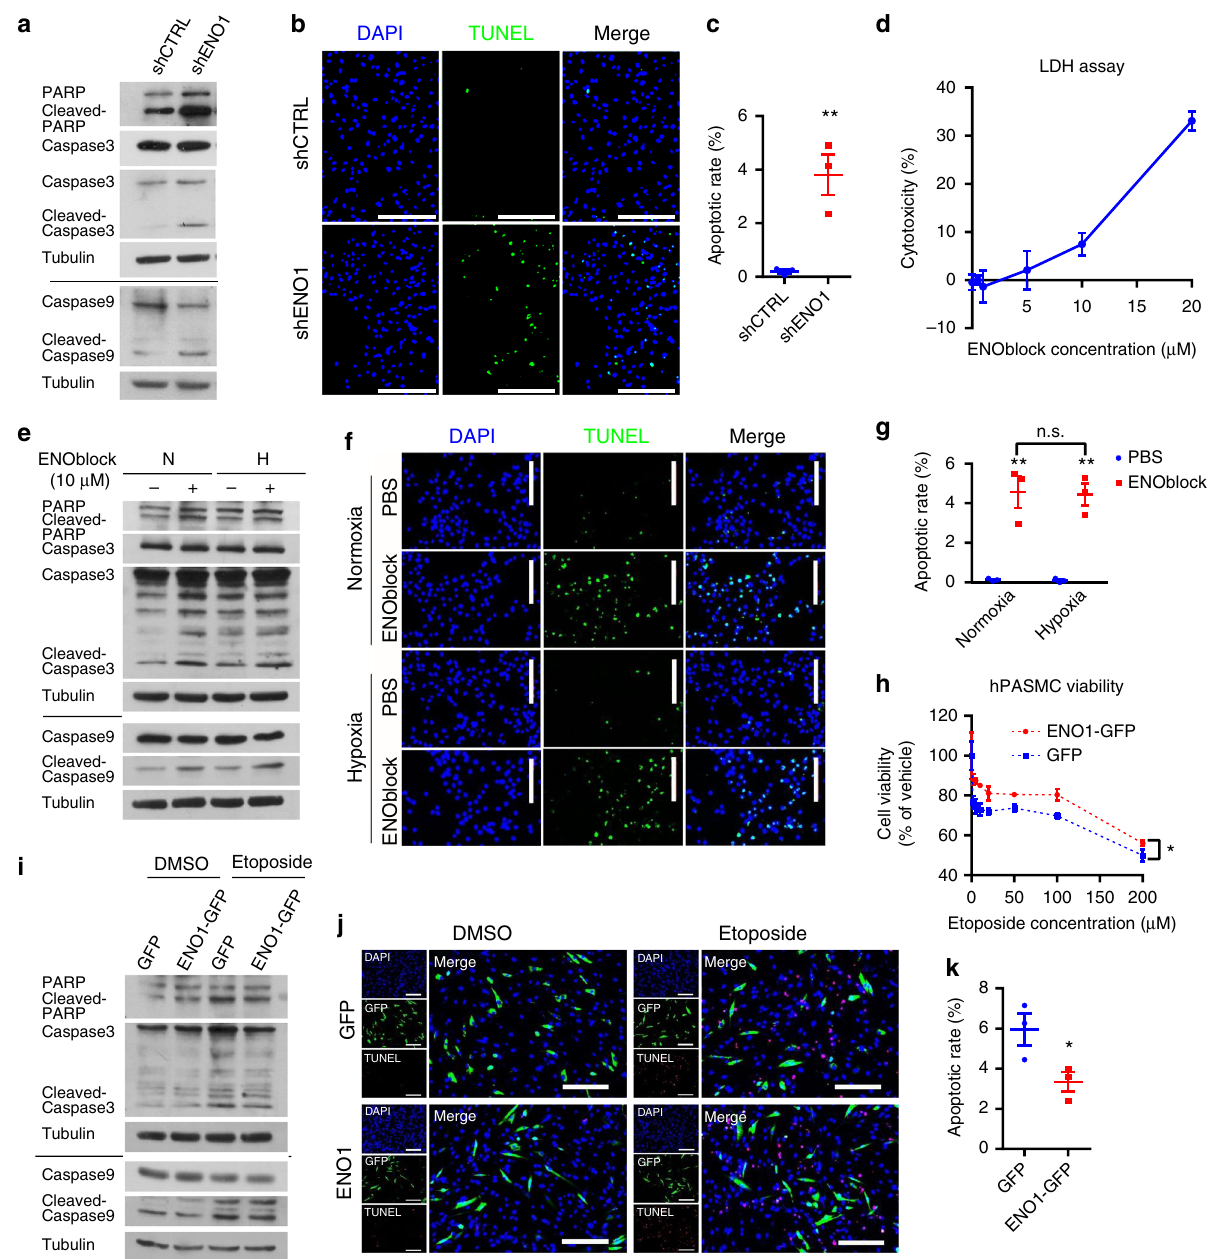
Fig. 3 ENO1 induces PASMC resistance to apoptosis. a The amount of apoptotic markers: PARP (full length and cleaved), caspase 3 (full length and cleaved), caspase 9 (full length and cleaved) were detected by western blotting in shENO1 – PASMC. b shENO1 and shCTRL PASMC were subjected to the TUNEL assay (Scale bars, 100 μ m) and c the apoptotic rates were calculated ( n = 3, ** P < 0.0001) with the TUNEL assay in shENO1 – PASMC. d PASMC were treated with ENOblock in different concentrations for 24 h, and the LDH assay was performed to detect cell death. e PASMCs were treated with 10 μ M ENOblock and hypoxia (1% O 2 ) for 24 h, and western blotting was used to detect apoptotic markers in cell lysate. f Images of the TUNEL assay (Scale bars, 100 μ m) and g calculated apoptotic rates ( n = 3 per group, ** P < 0.0001) in ENOblock-treated PASMCs under normoxic and hypoxic conditions. h PASMCs were transfected with pCMV3-ENO1-GFP and treated with etoposide (in gradient concentrations) for 24 h. Afterwards, the cell viability was measured ( n = 3 per group, * P < 0.05). i PASMCs were transfected with pCMV3-ENO1-GFP and treated with 100 μ M etoposide for 24 h. The apoptotic markers were detected using western blotting in the cell lysate. j Representative images of the TUNEL assay were shown (Scale bars, 100 μ m). k Apoptotic rates in ENO1-overexpressed PASMC under the treatment of etoposide were calculated from images in experiments depicted in j . n = 3 per group, * P = 0.04489. Data represent the mean ± SEM. Student t test and one-way ANOVA were used to compare two and multiple groups.